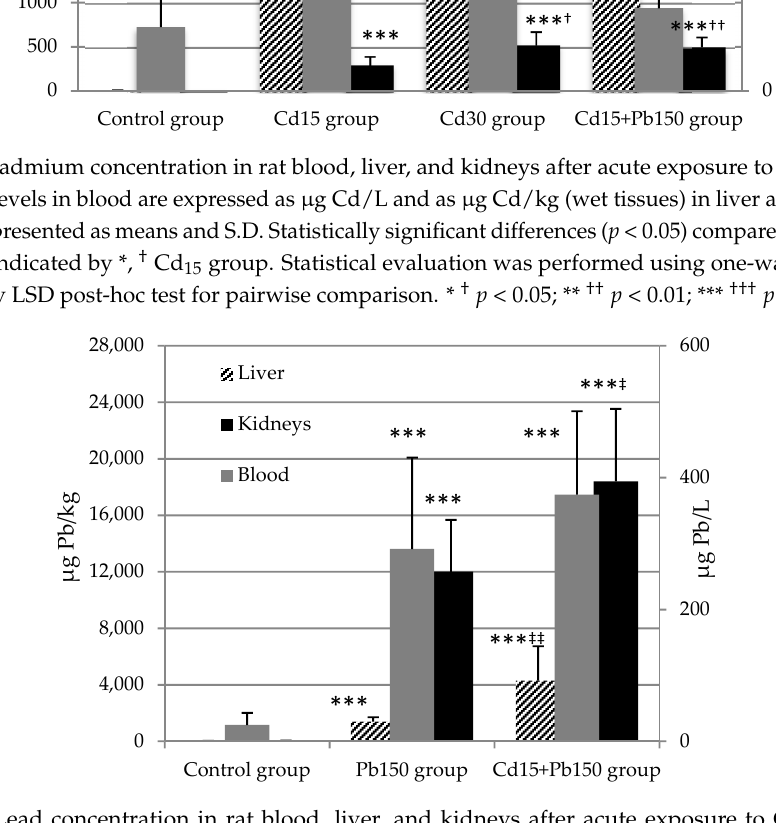
Figure 2. Lead concentration in rat blood, liver, and kidneys after acute exposure to Cd and Pb. Lead levels in blood are expressed as µg Pb/L and as µg Pb/kg (wet tissues) in liver and kidneys. Values are presented as means and S.D. Statistically significant differences ( p < 0.05) compared to control group are indicated by *, ‡ Pb 150 group. Statistical evaluation was performed using one-way ANOVA followed by LSD post-hoc test for pairwise comparison. * ‡ p < 0.05; ** ‡‡ p < 0.01; *** ‡‡‡ p < 0.001.